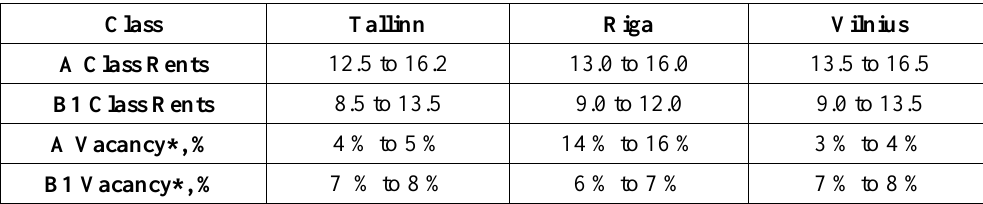
Table 2. Key office figures in the Baltic States in 2017Q1 (Colliers International, 2017a)